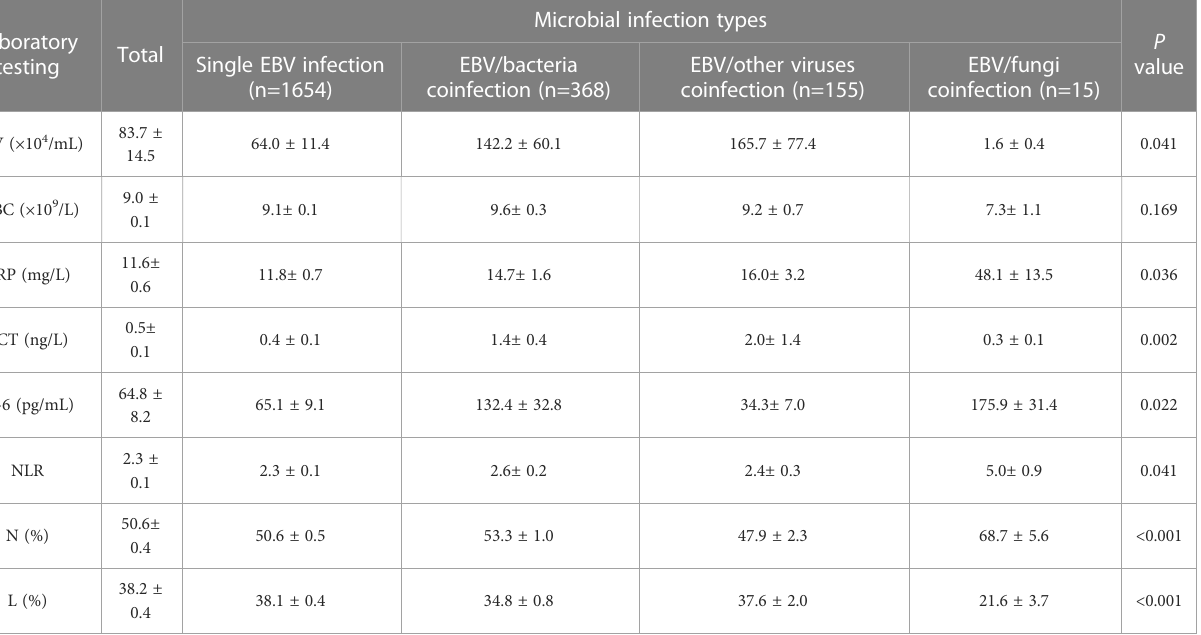
TABLE 1 Laboratory testing results among different types of EBV infections.